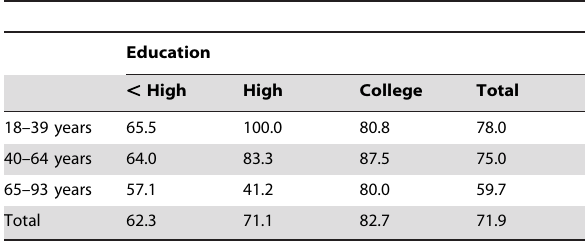
Table 4. Percentage of participants reporting memory difficulties according to age and education.